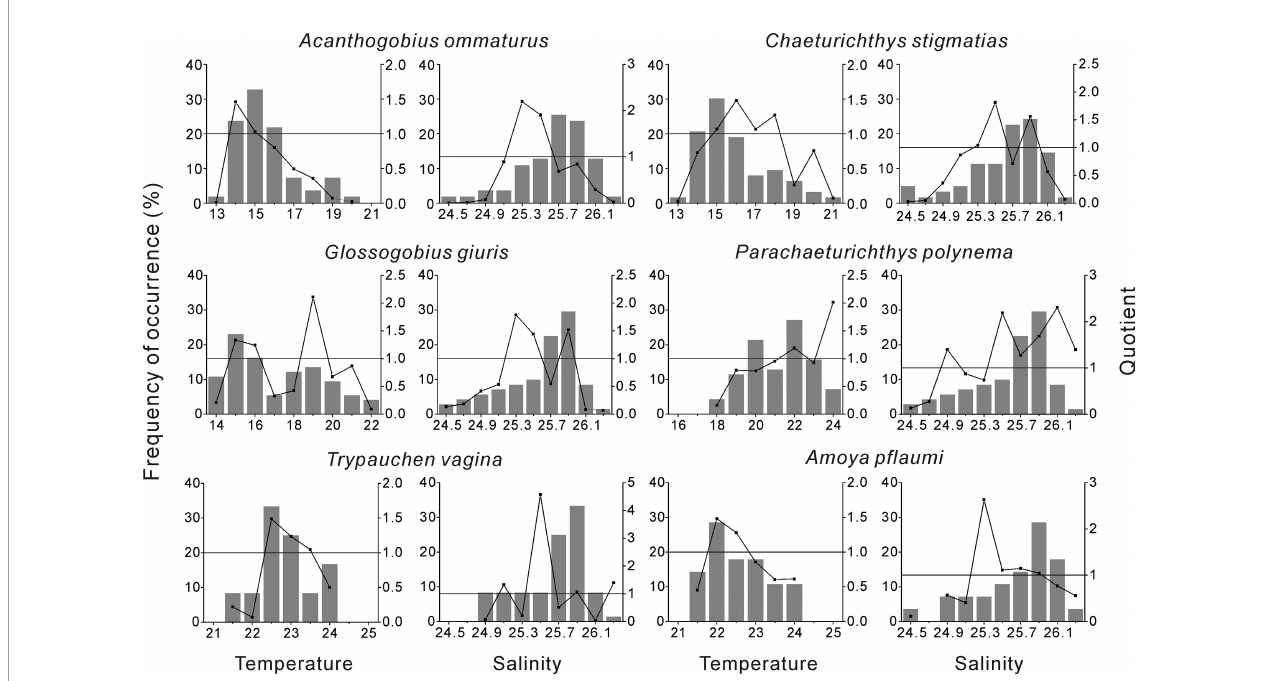
FIGURE 4 | Quotient rule analysis showing the frequency of occurrence of environmental variables (water temperature and salinity) and larval abundance/environmental variable quotient curves for each species. Horizontal solid lines indicate a unit quotient value; quotient values above this indicate positive selection (preference).